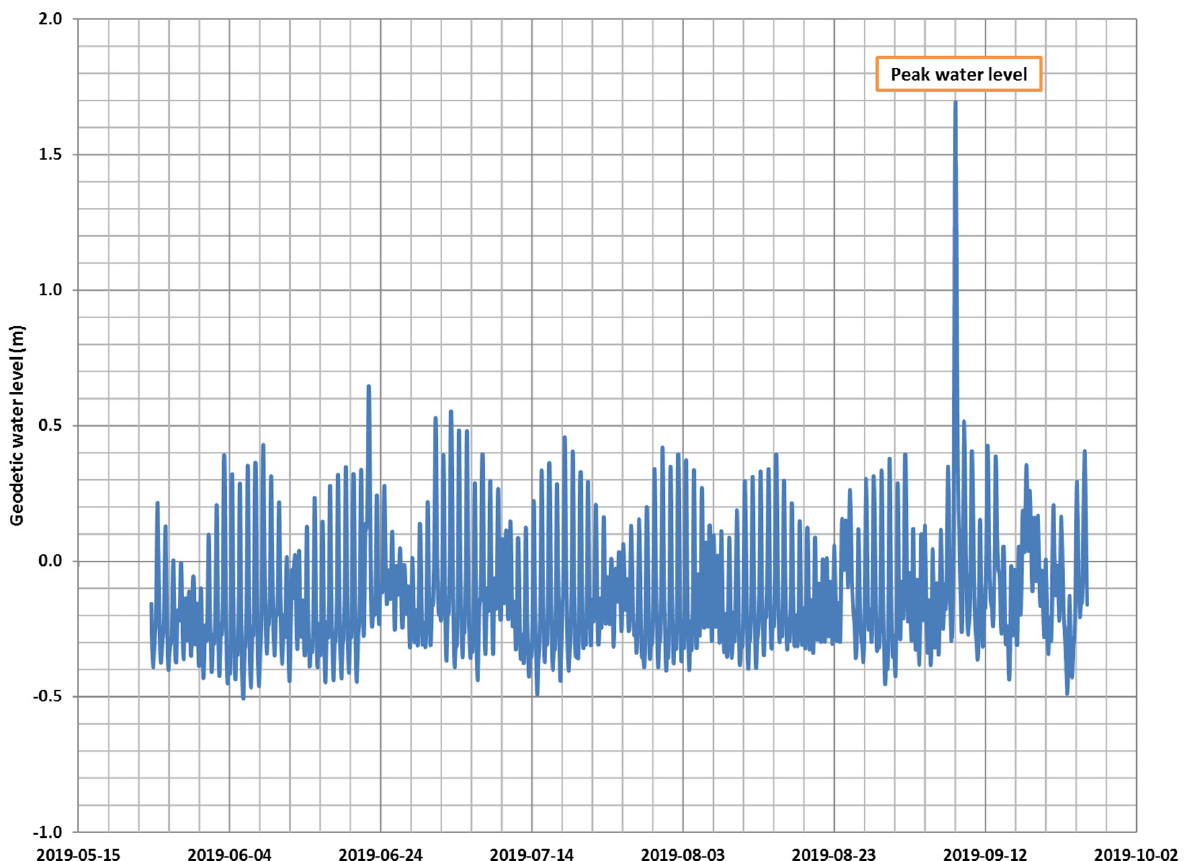
Figure 10. Observed tide gauge water levels in Darnley from 15 May to 2 Oct 2019.